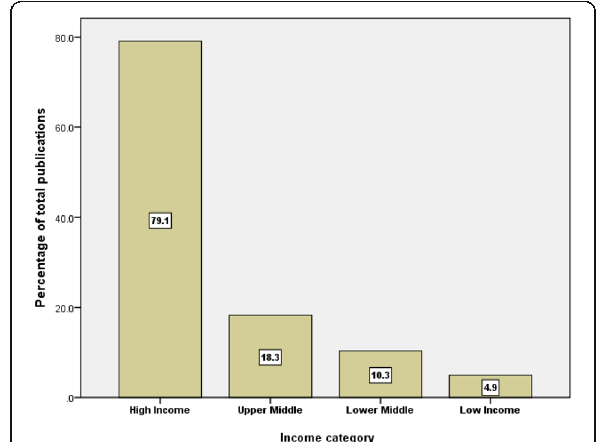
Fig. 4 Distribution of publications on HHR based on WHO world regions (1900 – 2017)